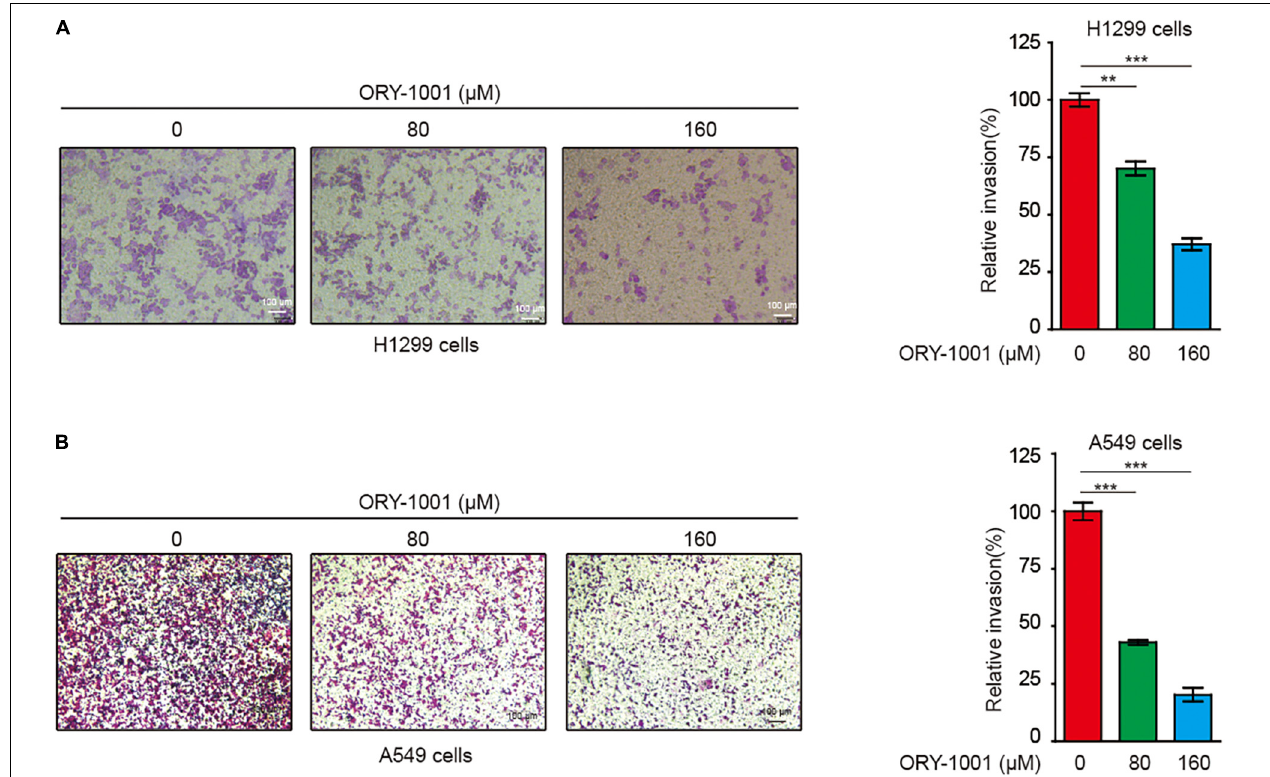
FIGURE 4 | ORY-1001 inhibits NSCLC cell invasion. (A) Transwell assay of cell invasion was performed in human lung cancer H1299 cells treated with or without ORY-1001. (B) Transwell assay of cell invasion was performed in human lung cancer A549 cells treated with or without ORY-1001 (**0.001 < p < 0.01; *** p <